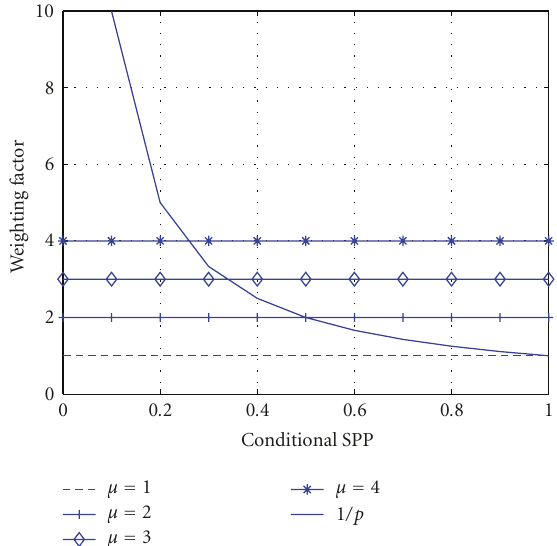
Figure 8: Speech presence probability-based weighting factor compared to a fixed weighting